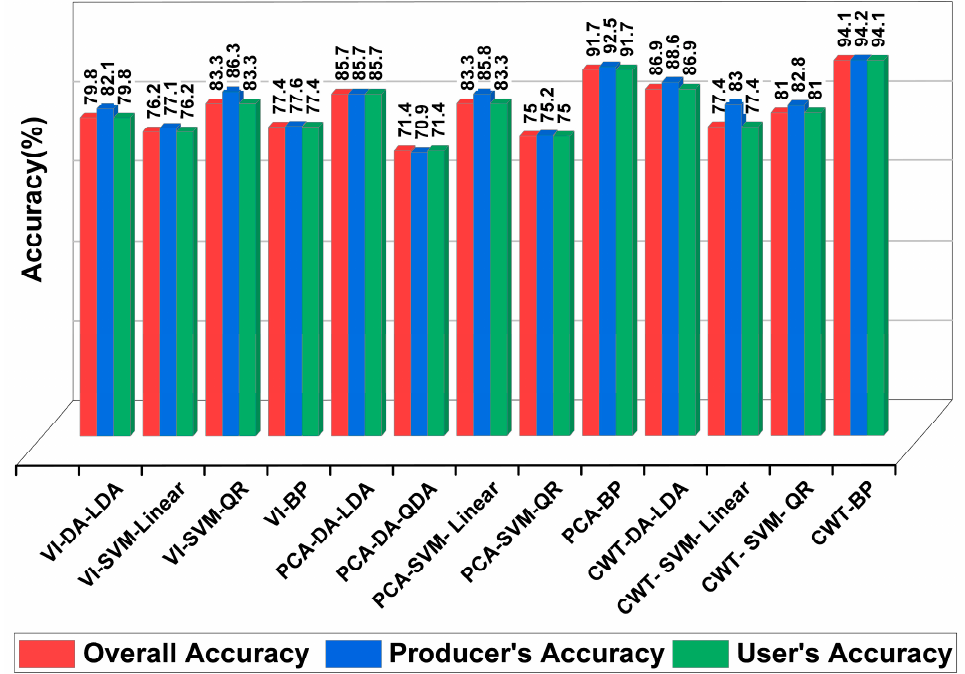
Figure 6. Comparison of accuracy of different features and discrimination methods—training samples ( 𝑛 = 84 ).